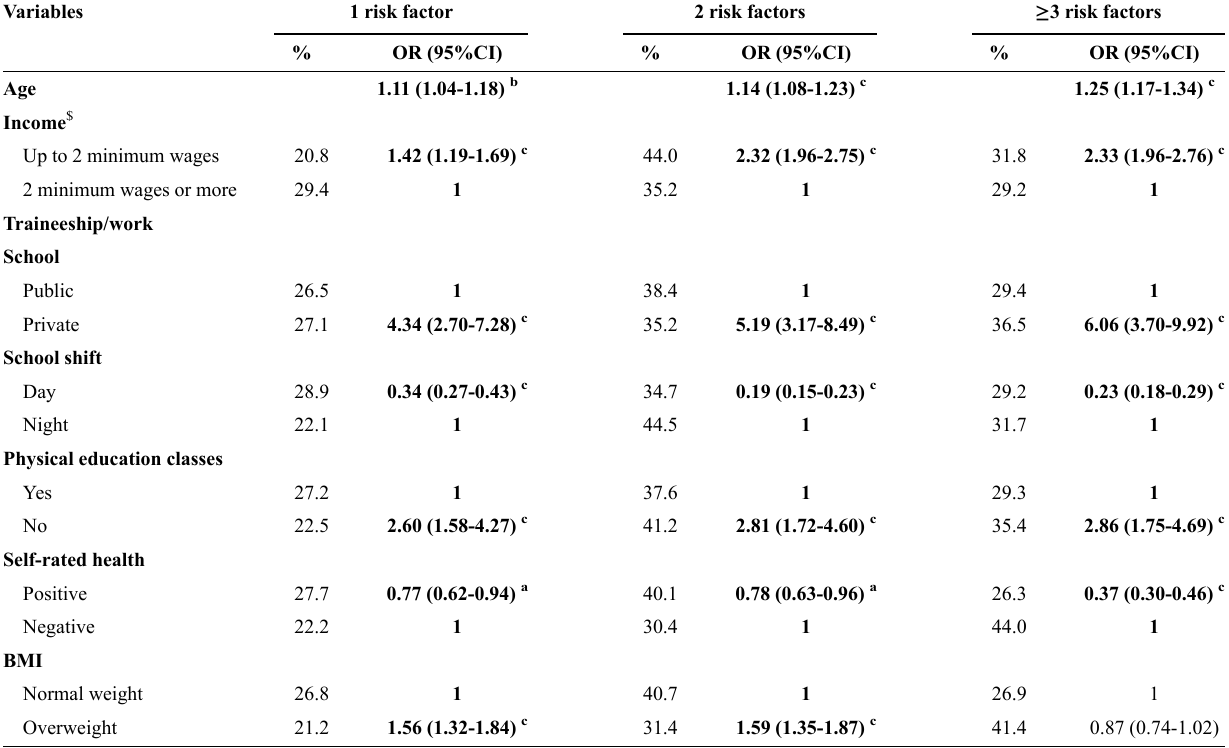
Table 3 - Multinomial analysis ₡ of modifiable risk factors for CVD and associated factors in boys. ACtVU Study. Uberaba, Brazil (2015).